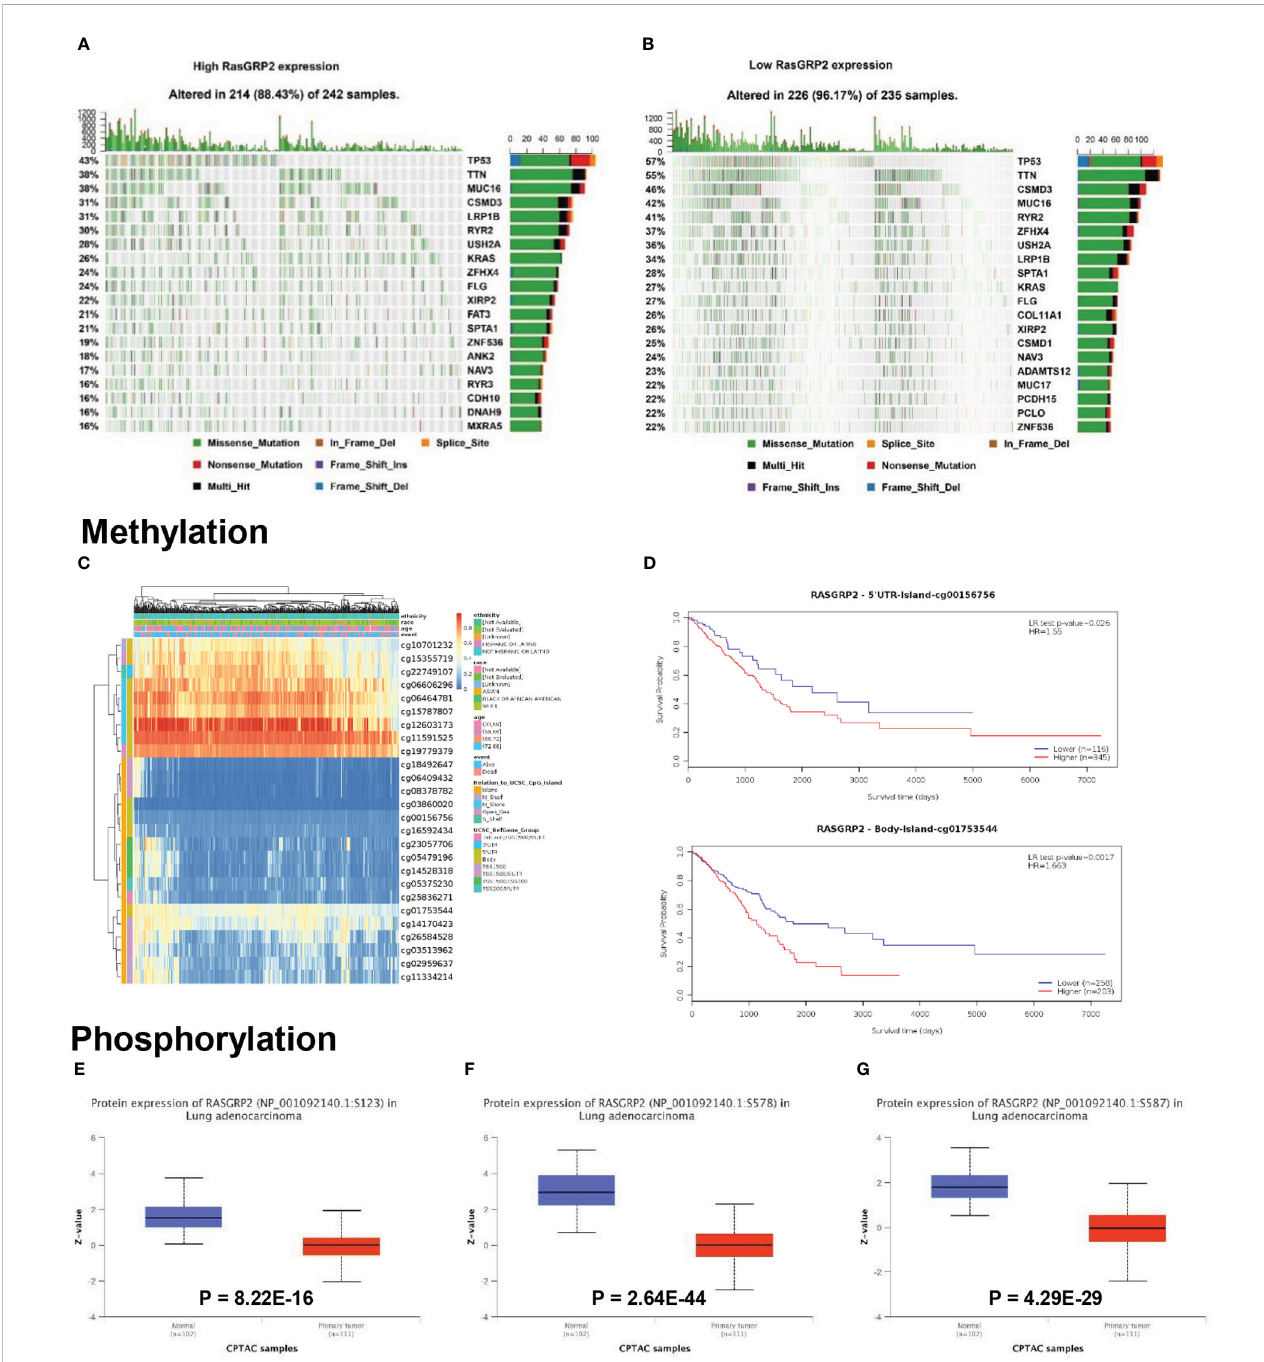
FIGURE 4 Mutation, methylation and phosphorylation of RASGRP2 in LUAD. (A, B) Differential somatic mutations were found in LUAD with high and low RASGRP2 expression. (C) Heatmap between the methylation level and RASGRP2 expression. (D) Prognostic value of cg00156756 and cg01753544. (E – G) The phosphorylation of RASGRP2 at S123, S578, S587 was analyzed in LUAD. The results were obtained from the UALCAN